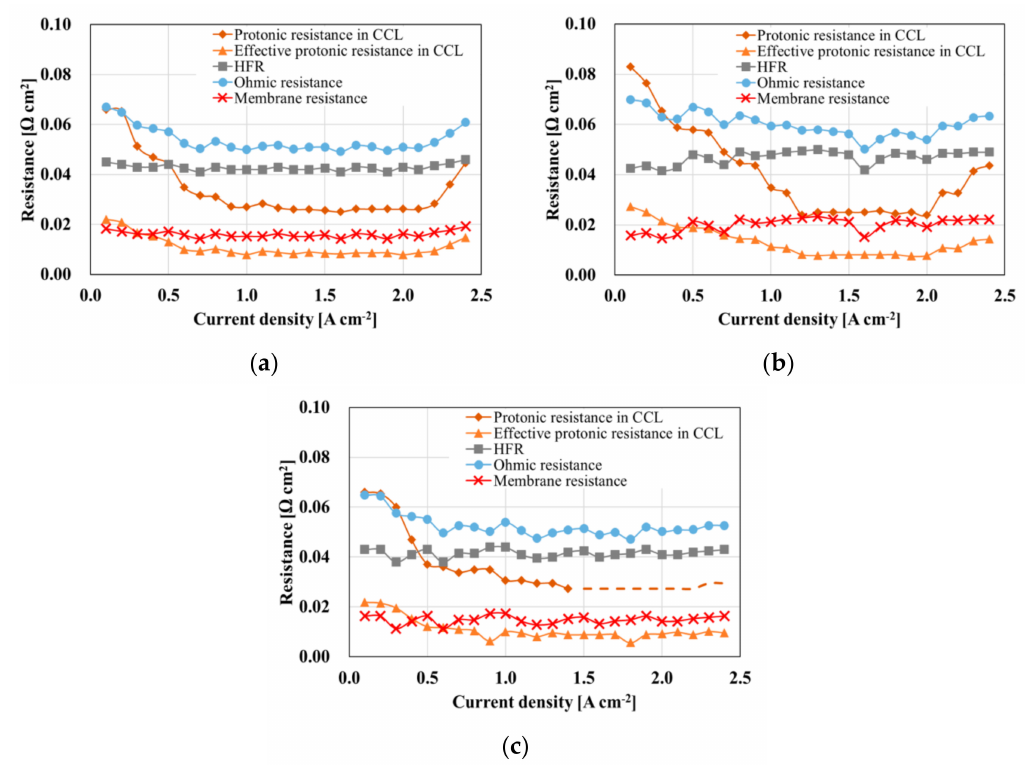
Figure 7. Separation of the ohmic resistance at ( a ) RH 100% under H 2 /air, ( b ) RH 80% under H 2 /air, and ( c ) RH 100% under H 2 /Heliox. The rhombus symbol is the R p , triangle symbol is the R ef f , the square symbol is HFR , and the circle symbol P is ohmic resistance. At the dotted line, the fitting of the EIS was not well fitted, so protonic resistance in CCL cannot be evaluated. In this region, resistance separation was conducted using the correlation between EIS and the polarization